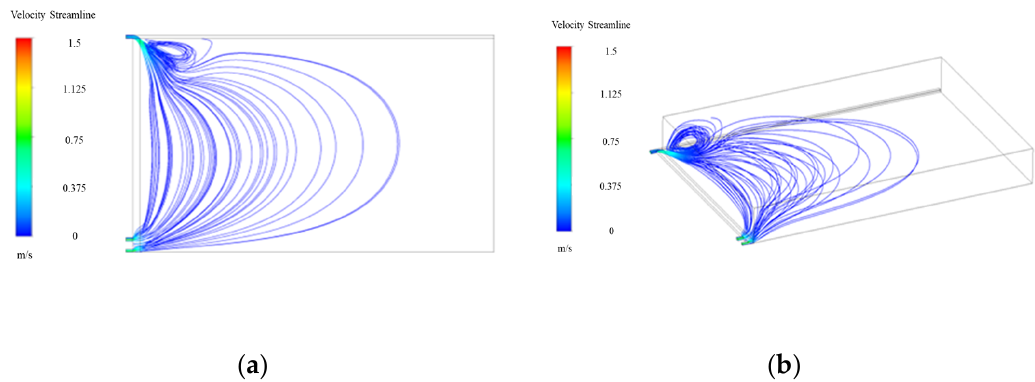
Figure 8. Distribution map of wind velocity and flow field in gob during caving (own elaboration). ( a ) A 2D wind velocity field map. ( b ) A 3D wind velocity field map.